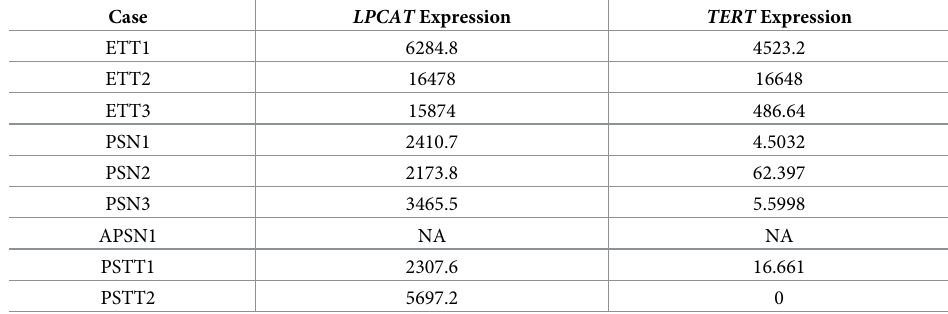
Table 4. LPCAT and TERT expression levels (DESeq2 normalized counts) for all GTD